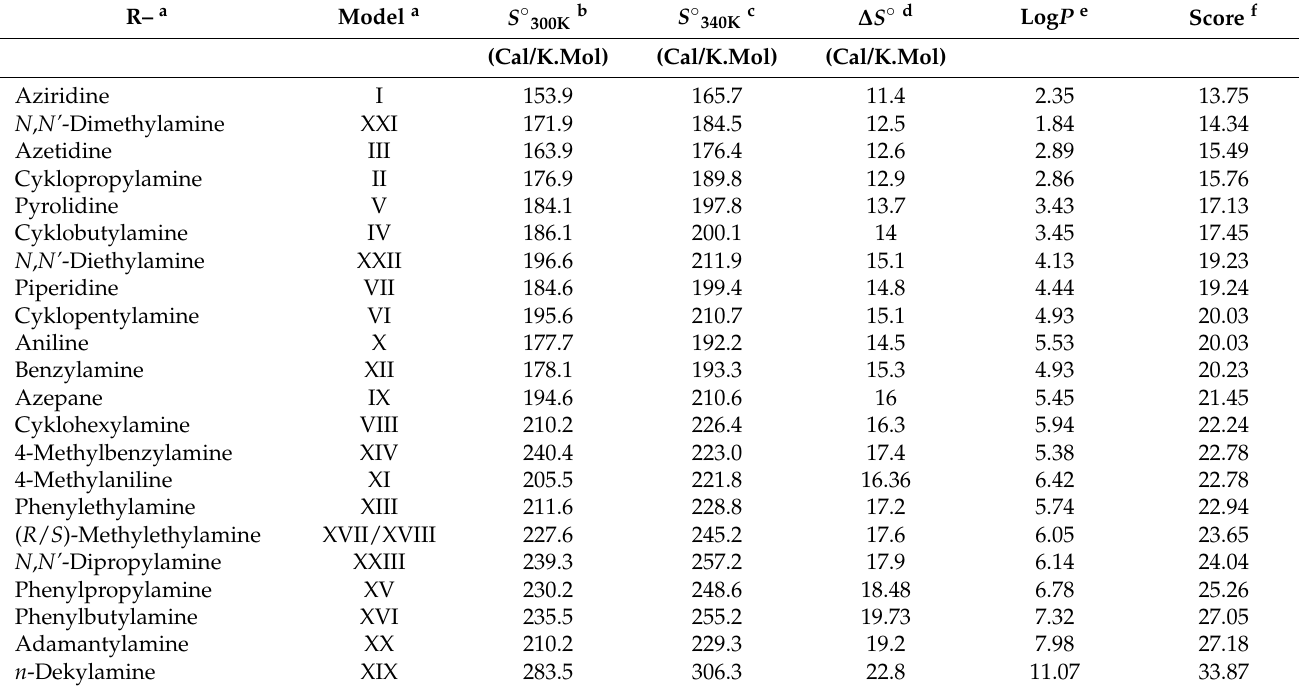
a : A substituent at the location of 3 and 6 in the structure of the ureas models I–XXIII. b : Standard entropy for urea models I–XXIII at a temperature of 300 K. c : Standard entropy for urea models I–XXIII at a temperature of 340 K. d : Gap of the standard entropy for urea models